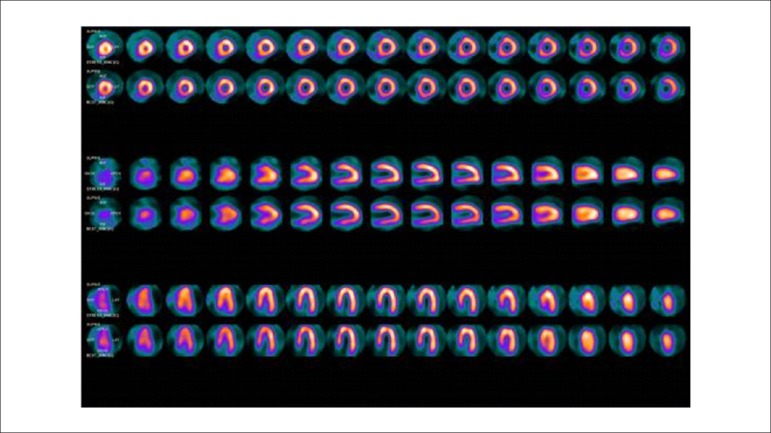
Case 8 - Myocardial perfusion scintigraphy within normality. Images acquired with dedicated cardiac equipment, equipped with solid cadmium-zinc-tellurium detectors.